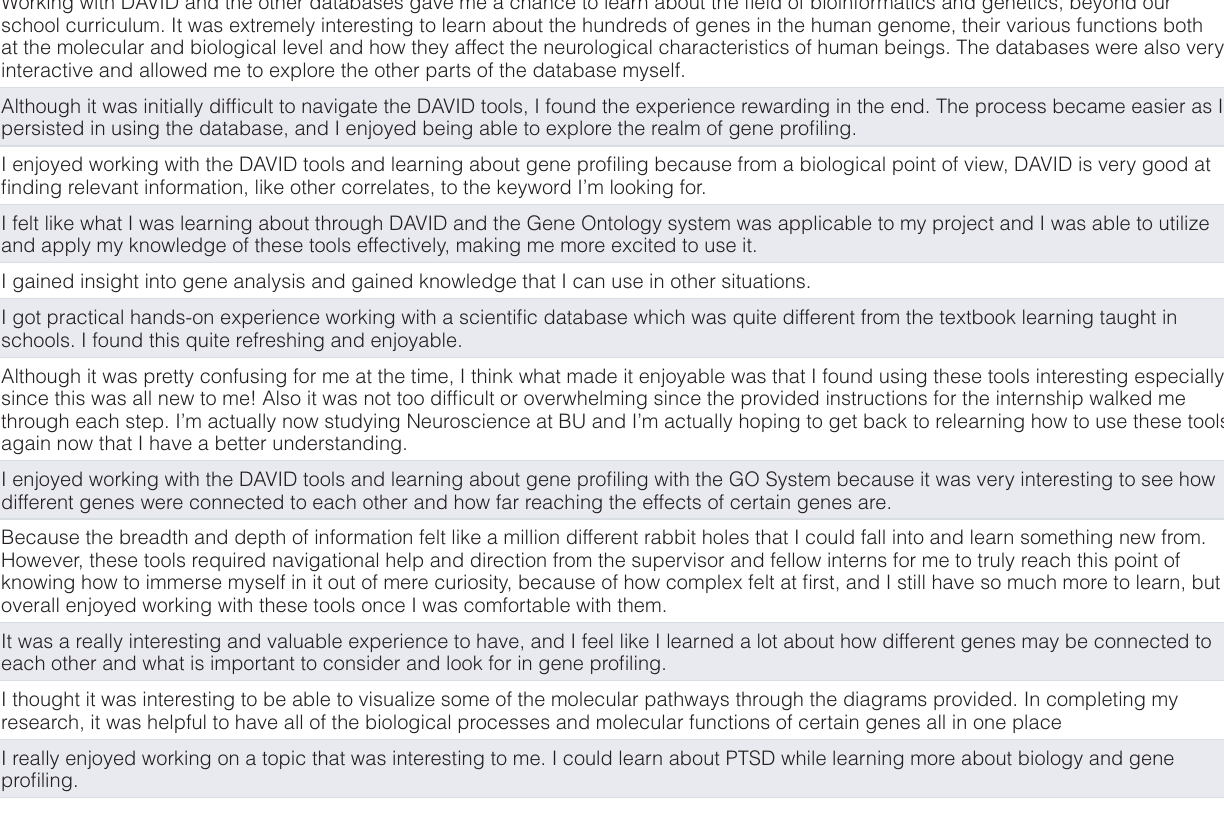
Table 3. Student Short Answer Responses to question 4a. (Question 4. Did you enjoy working with the DAVID tools and learning about gene analysis/profiling with the Gene Ontology System?) 4a: If yes, please explain why?. Working with DAVID and the other databases gave me a chance to learn about the field of bioinformatics and genetics, beyond our school curriculum. It was extremely interesting to learn about the hundreds of genes in the human genome, their various functions both at the molecular and biological level and how they affect the neurological characteristics of human beings. The databases were also very interactive and allowed me to explore the other parts of the database myself. Although it was initially difficult to navigate the DAVID tools, I found the experience rewarding in the end. The process became easier as I persisted in using the database, and I enjoyed being able to explore the realm of gene profiling. I enjoyed working with the DAVID tools and learning about gene profiling because from a biological point of view, DAVID is very good at finding relevant information, like other correlates, to the keyword I’m looking for. I felt like what I was learning about through DAVID and the Gene Ontology system was applicable to my project and I was able to utilize and apply my knowledge of these tools effectively, making me more excited to use it. I gained insight into gene analysis and gained knowledge that I can use in other